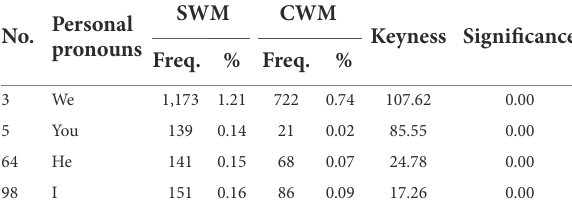
TABLE 2 Key personal pronouns in SWM (in comparison with